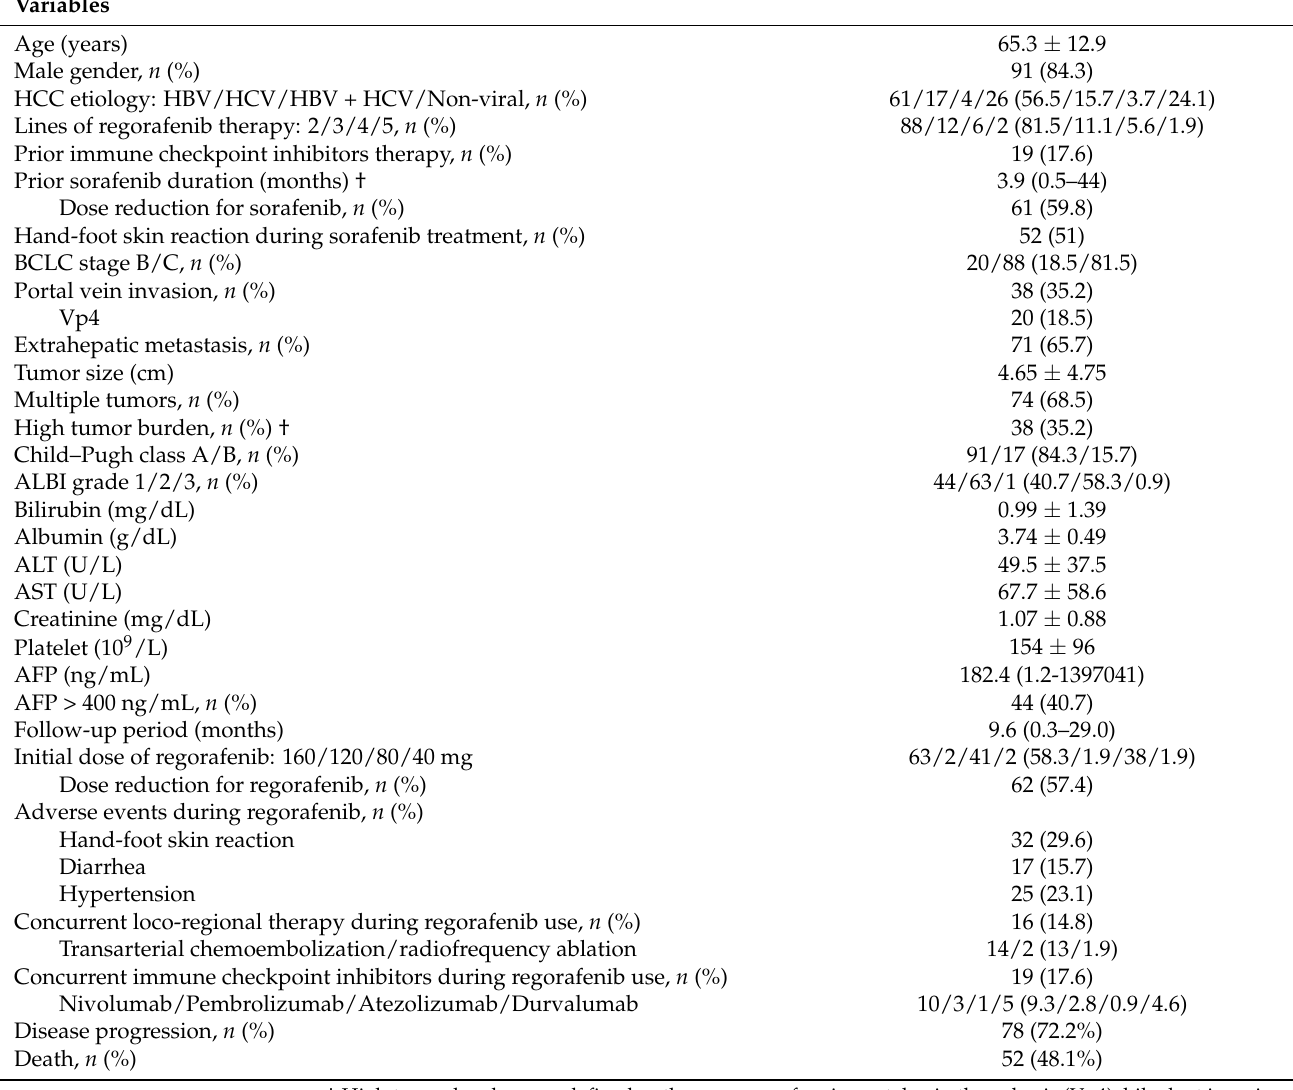
Table 1. Characteristics of 108 patients receiving regorafenib